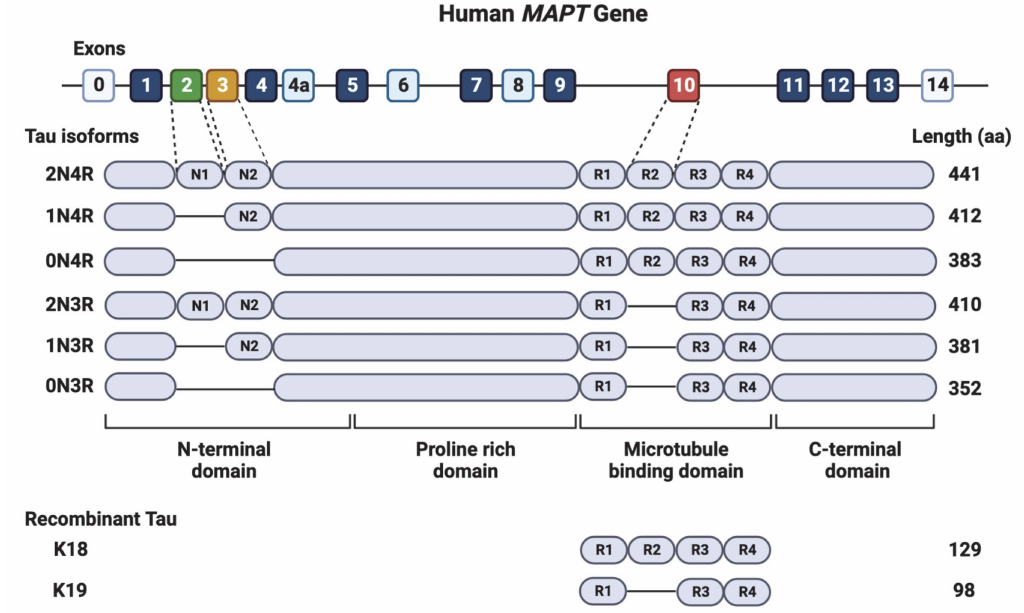
Figure 1. Human MAPT gene. The MAPT gene encodes human tau and contains 16 exons. E0 and E14 are transcribed but not translated. E1, E4, E5, E7, E9, E11, E12, and E13 are constitutive, and E4a, E6, and E8 are transcribed only in peripheral tissue. The alternative splicing of E2, E3, and E10 generates six tau isoforms seen in normal human brains. The recombinant tau proteins K18 and K19 contain four (R1–R4) and three repeats (R1, R3, R4) of the microtubule-associated domain,